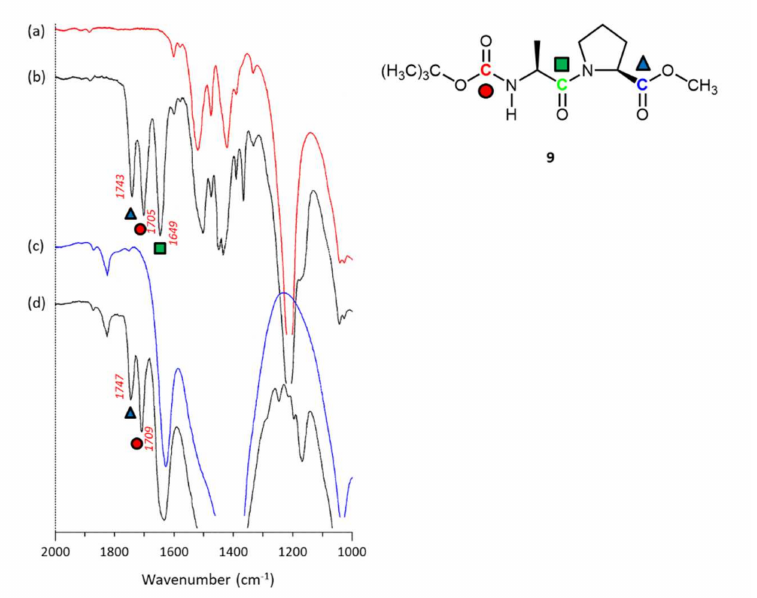
Figure 18. IR spectra of N -Boc-L-alanine-L-proline-OMe 9 : ( a ) CHCl 3 (red line); ( b ) 20 mmol/L of 9